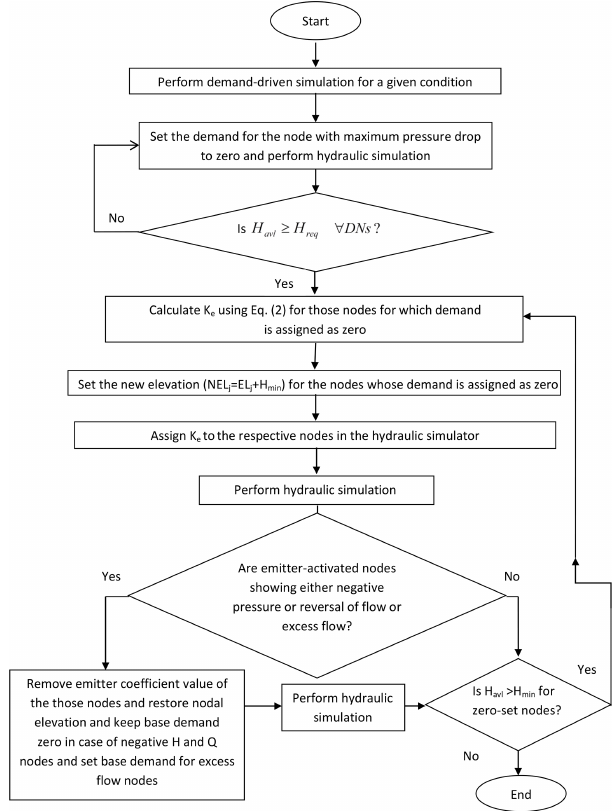
Figure 2. Flow chart illustrating the computational steps involved in the proposed approach.